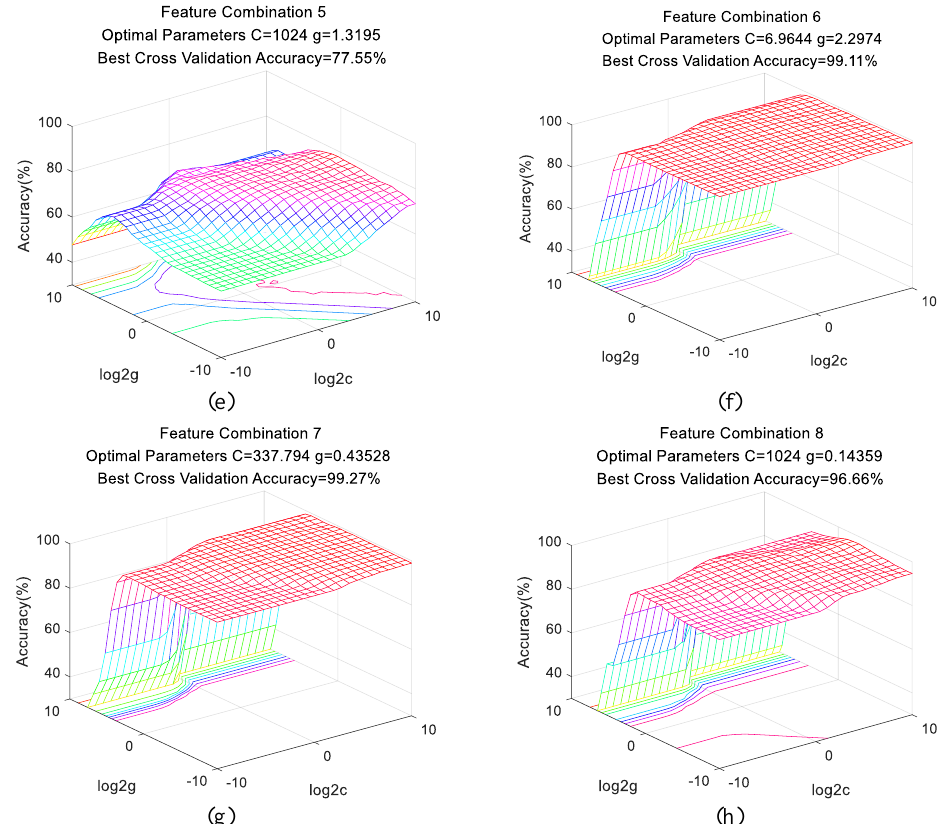
Figure 7. The best optimization results of parameters C and g under different parameter characteris-